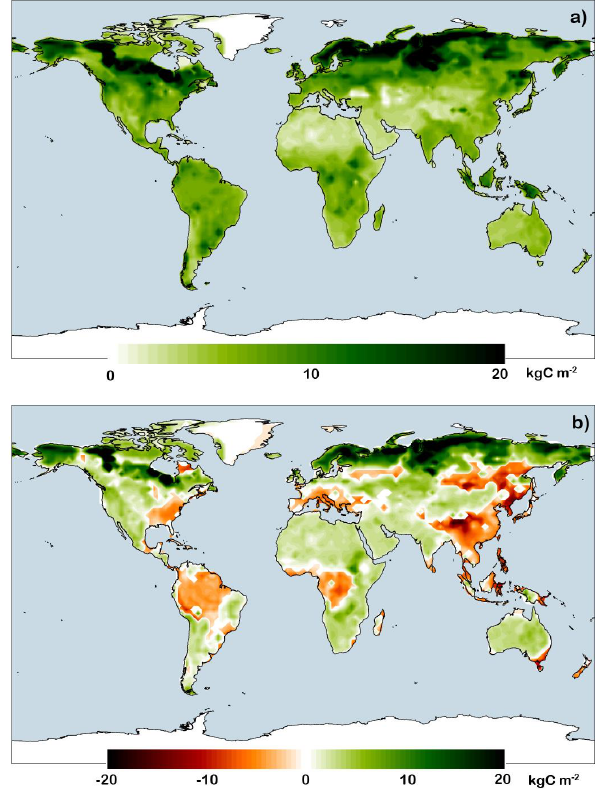
Figure 3. Soil carbon from the ISRIC-WISE data set (a) and the dif- ference between this and simulated SOC with the standard (unmod- ified) CLM at equilibrium ( OBS − ES ) (b) . Data from the ISRIC- WISE data set were recalculated for stocks in the top 1m and a weighted average over map units was produced. A full description of the calculation method is given in the